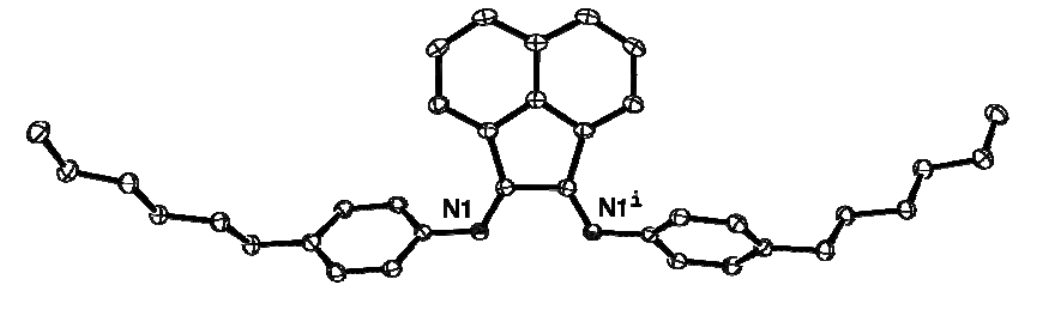
Figure 2. ORTEP diagram of L with 50% probability thermal ellipsoids. Hydrogen atoms are omitted for clarity. L lies on a two-fold axis (-x, y, 3/2-z) and as a result, N1 i is equivalent to